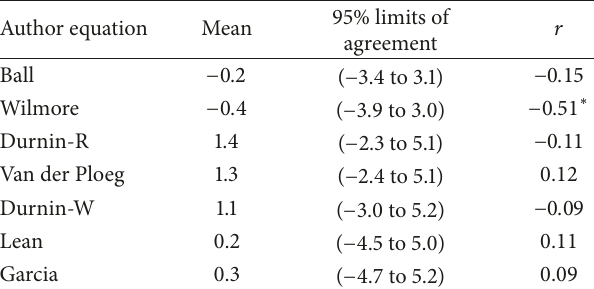
Table 7: Body fat percentage differences (equation − DXA) from anthropometric equations (developed in nonathletic populations) statistically similar to